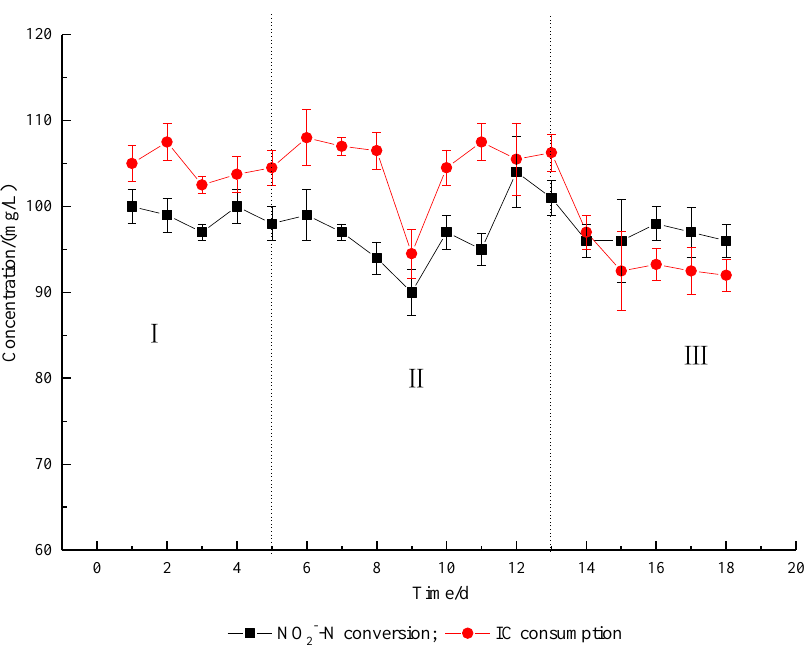
Figure 3. Relationship between inorganic carbon (IC) consumption and NO 2 − -N production in partial nitrification; Stages I, II, and III indicate that HRT is 14, 10, and 6 h, respectively.